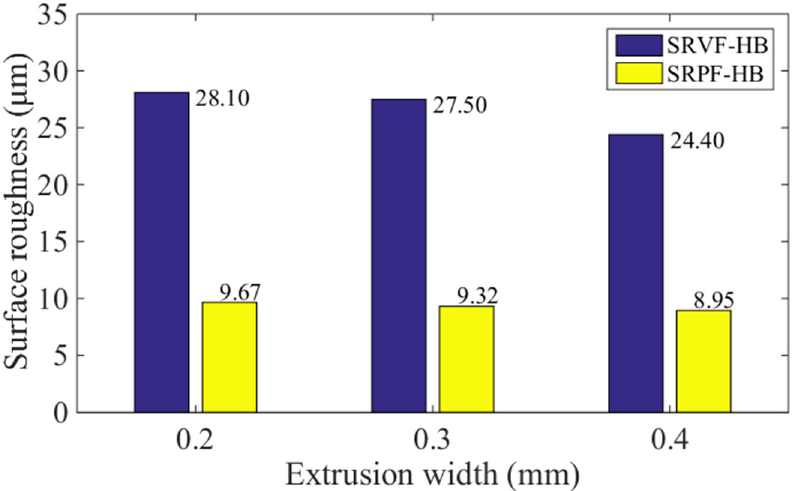
Figure 14. Effect of different extrusion width on the SRVF-HB and SRPF-HB.